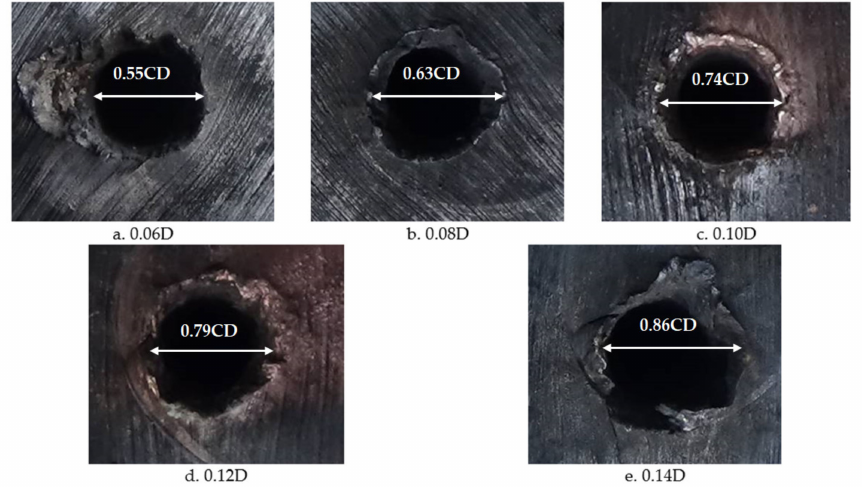
Figure 16. Images of shaped charges with different wall thicknesses acting on the steel target. The comparison between the numerical simulation and experimental results of the steel target with different wall thicknesses of the reactive charge liner is shown in Figure 17. The experimental value of the penetration depth into the steel target with different wall thicknesses was consistently lower than the numerical simulation value, but the diameter of the perforation was greater than the numerical simulation value. Although there are some differences between the numerical simulation results and the experimental results, it also qualitatively shows that the penetration law of the shaped charge with different wall thicknesses is similar to the metal jet.